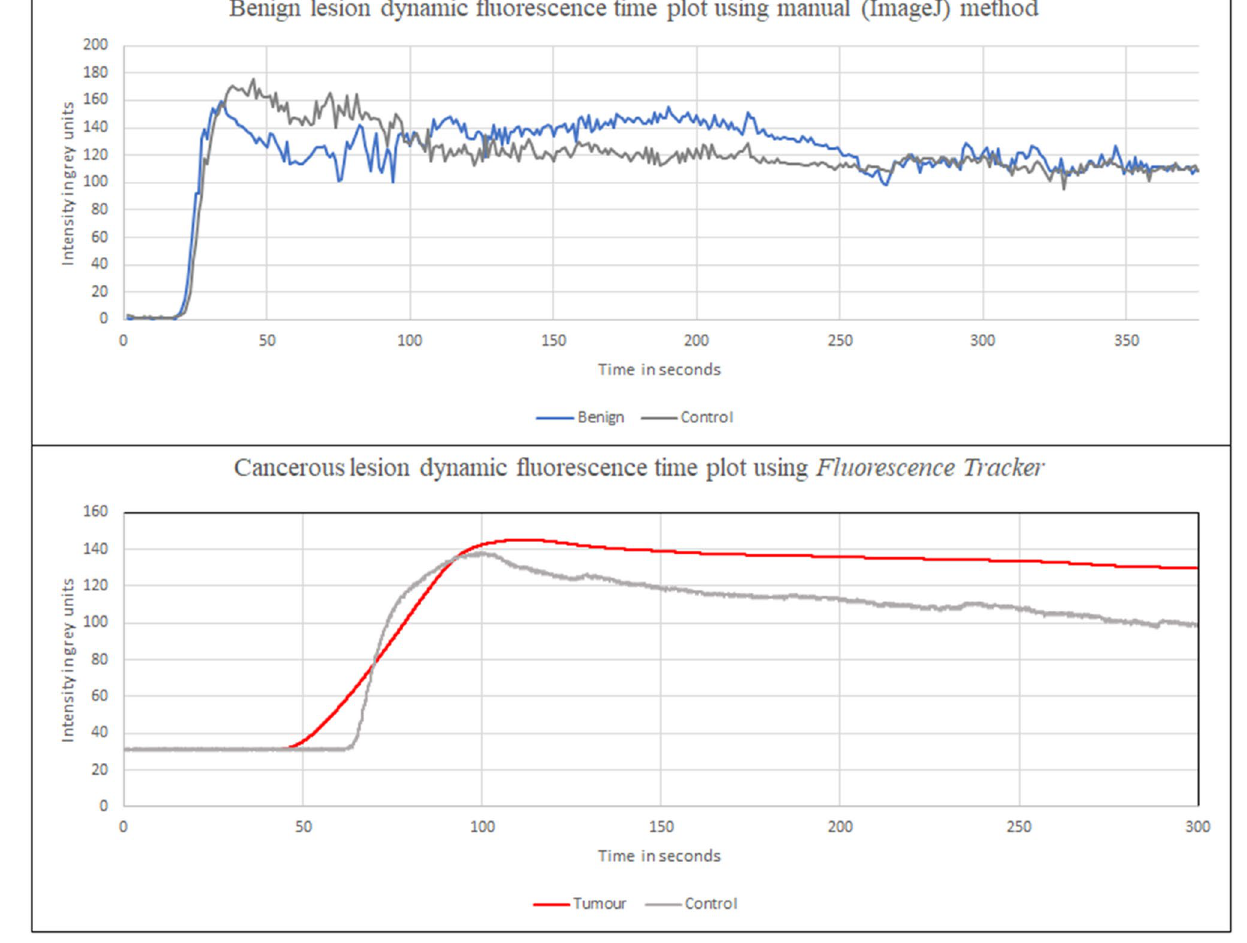
Figure 8. Illustrative example graphs (Microsoft Excel for Microsoft 365) of dynamic time vs fluorescence signal intensity plots for both ( a ) a benign lesion using the manual (ImageJ) method above and ( b ) a cancer using the automated Fluorescence Tracker App for endoluminal in vivo assessment while injecting 0.25 mg/kg